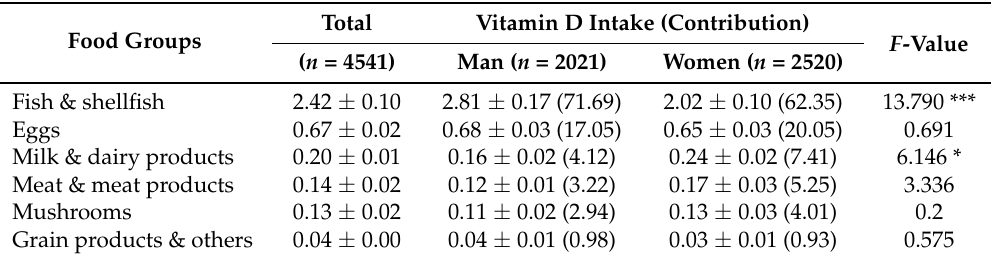
Table 4. Contribution of vitamin D-rich food groups towards the daily mean intake of vitamin D in Korean